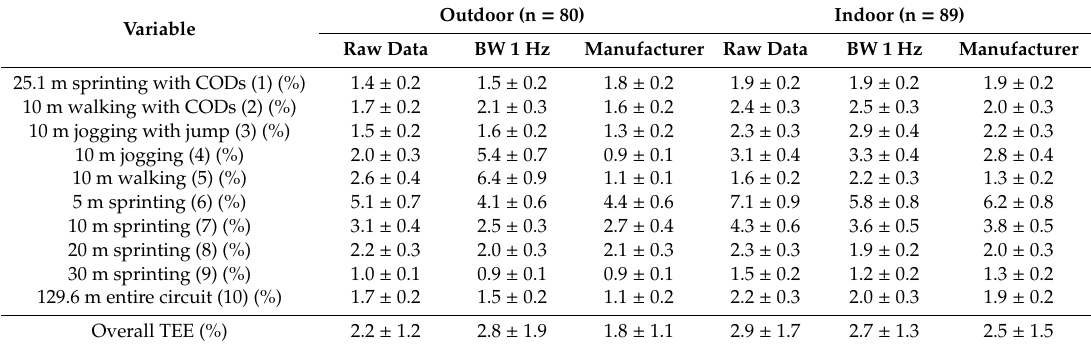
Table 3. Relative typical error of estimates (mean ± SD) of the local positioning system for determining the distances covered during outdoor and indoor conditions. The impacts of the different filtering techniques, and the outcomes of the raw data, are also shown.